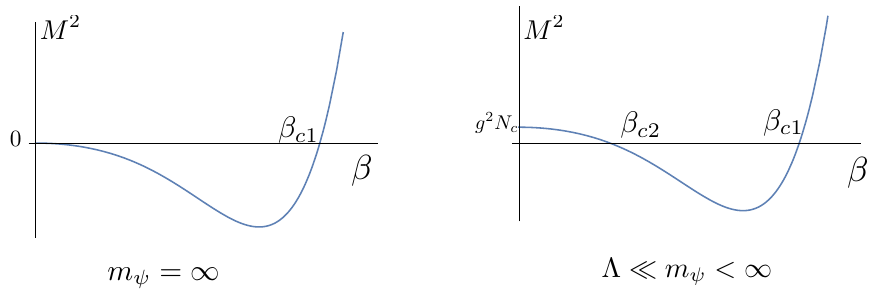
Figure 15 . The mass square for gauge holonomy. m ψ = ∞ , 0 < m λ (cid:28) Λ of QCD(F/adj) is N = 1 SYM with soft supersymmetry breaking mass term. The center-symmetry changing phase transition is analytically calculable, and takes place at β . When m , the fundamental c 1 ψ < ∞ fermions with Ω 0 twist always gives a center-stabilizing contribution, and the center-symmetry F always restores at arbitrarily small- β . This gives an example of two calculable phase